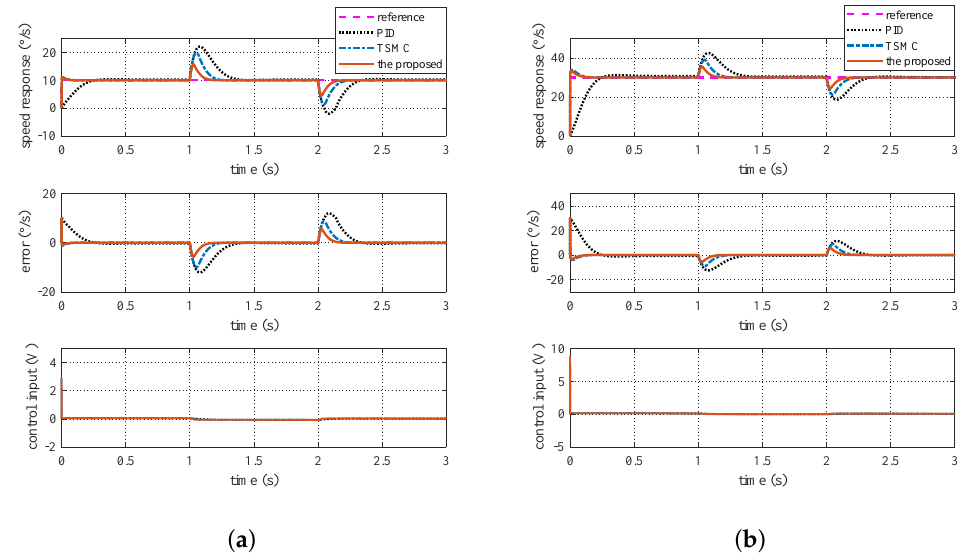
Figure 8. Simulation response curves under Case II: ( a ) Step reference signal with 10 ◦ /s; ( b ) step reference signal with 30 ◦